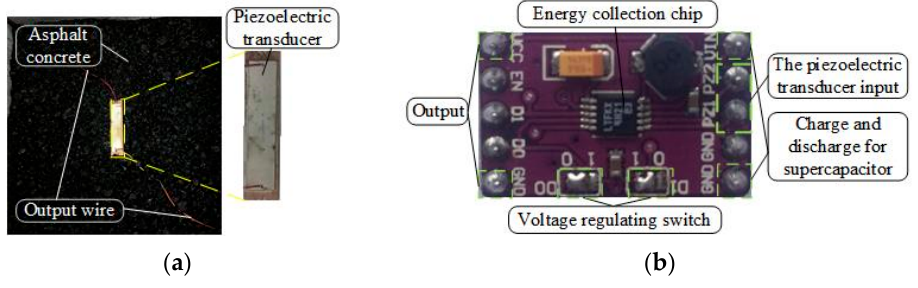
Figure 3. Road energy collection: ( a ) The harvester; ( b ) power management.